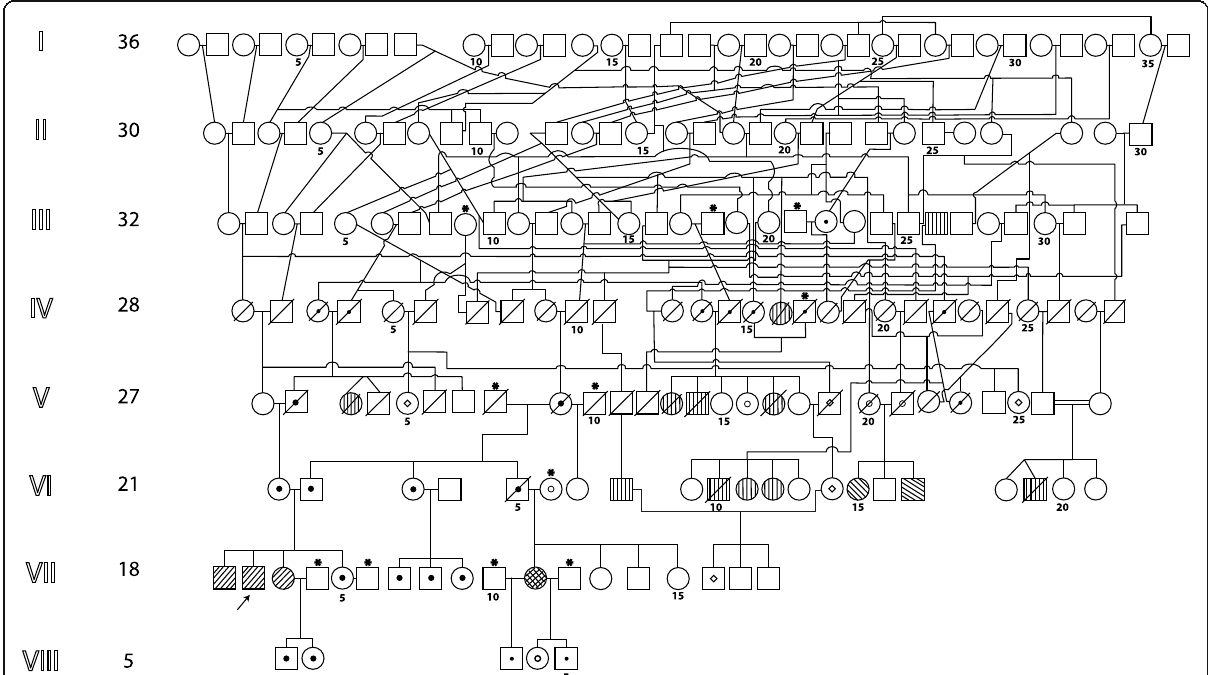
Fig. 1 Extended genealogy of the nuclear families in the isolate, from years 1862 to 2019. Abridged pedigree of 200+ kinship-related (from 9 original nuclear families) prelingual/profound deaf subjects figured as vertically hatched = those with any unidentified specific etiology; mutant GJB2 homozygotes are either, if left-bent = c.35dupG; if right-bent = c.35delG; if crisscrossed = compound heterozygous c.35dupG/c.35delG. Large inner central dot = filled: obligate c.35dupG heterozygotes; hollow: suspected/tested c.35delG heterozygotes. Small inner central dot = obligate heterozygotes. Hollow inner central rhomb = obligate p.W77R (p.Trp77Arg) carriers. *Subject with no German ancestry. All persons from generation IV and upwards were deceased. From generation V on, all living individuals were DNA